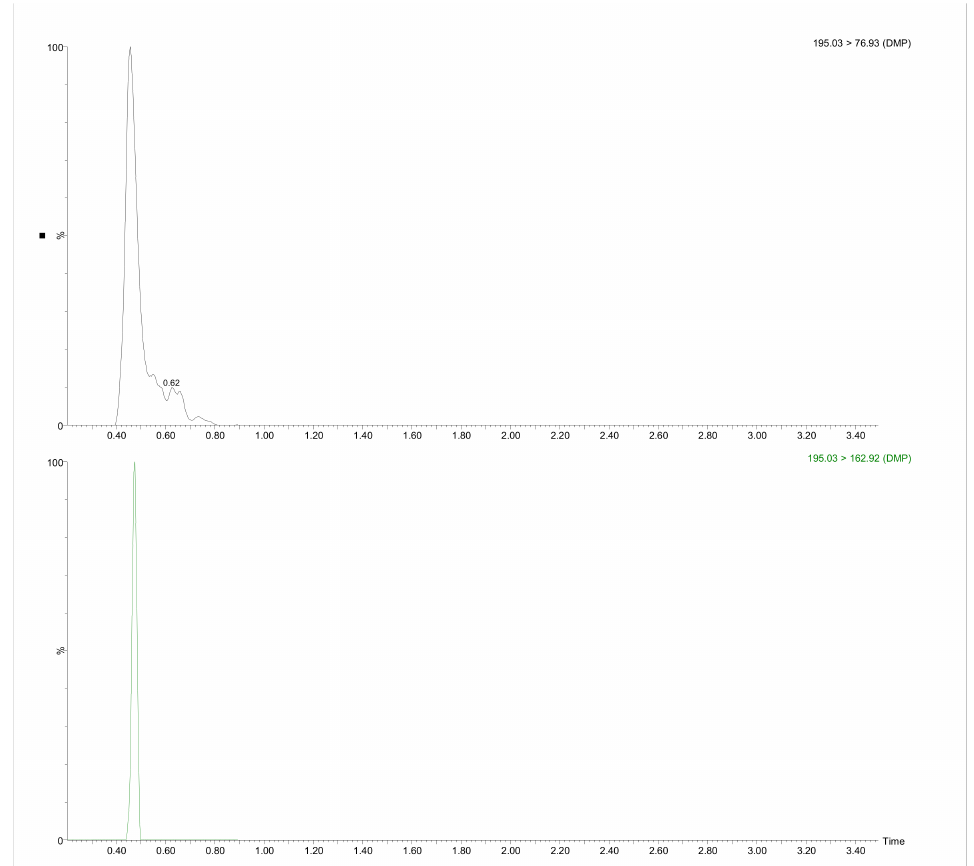
Figure 2. UHPLC-MS/MS chromatogram for detected analyte (DMP) in sample K2 submitted to the developed extraction